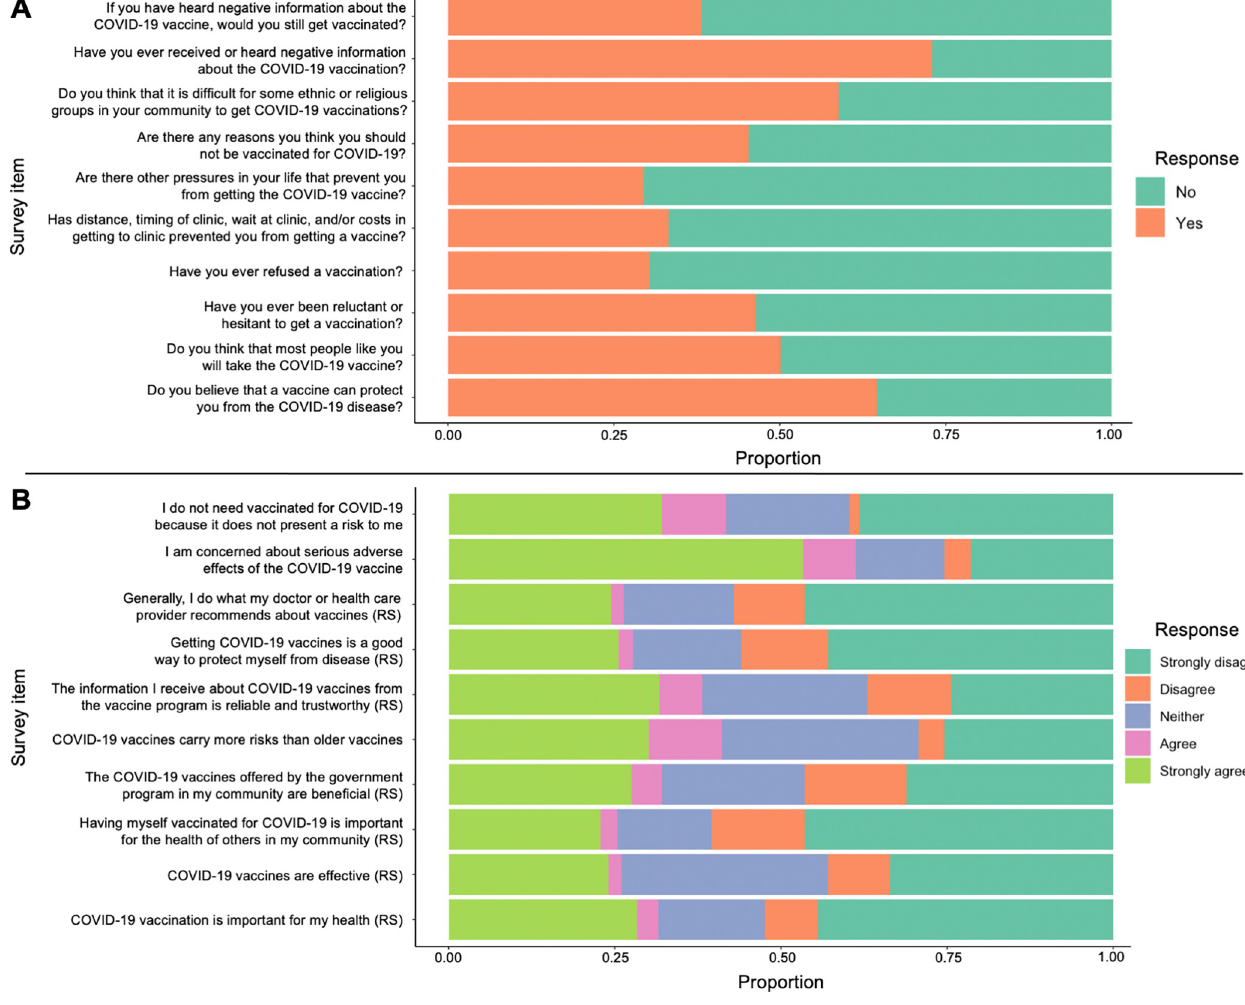
Fig 1. Distribution of participant responses to the 10 binary (Panel A) and 10 Likert items (Panel B) of the modified WHO SAGE Vaccine Hesitancy Survey. RS suggests the item was reverse scored for the Vaccine Hesitancy